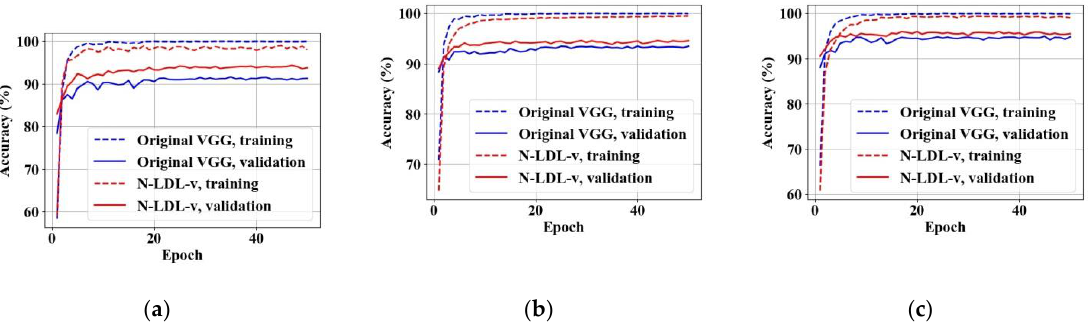
Figure 12. Learning curves of original VGG and N-LDL-v on ( a ) AID-0.2, ( b ) Aug AID-0.2, and ( c ) AID-0.5.